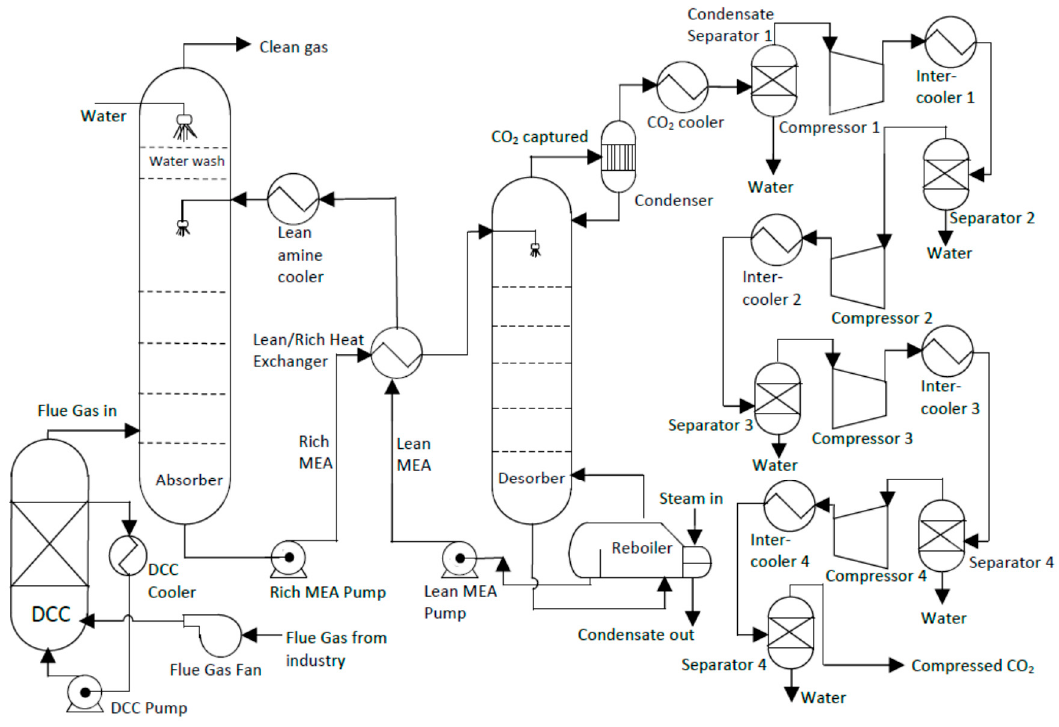
Figure 1. Flowsheet of the standard process.